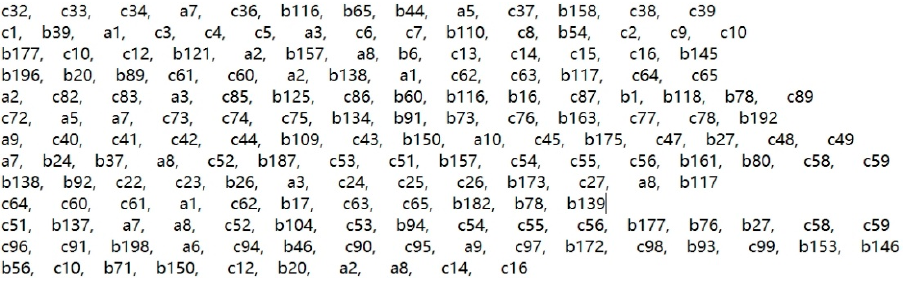
Figure 9. A fragment of the second type of data. Each row denotes an intrusion session.